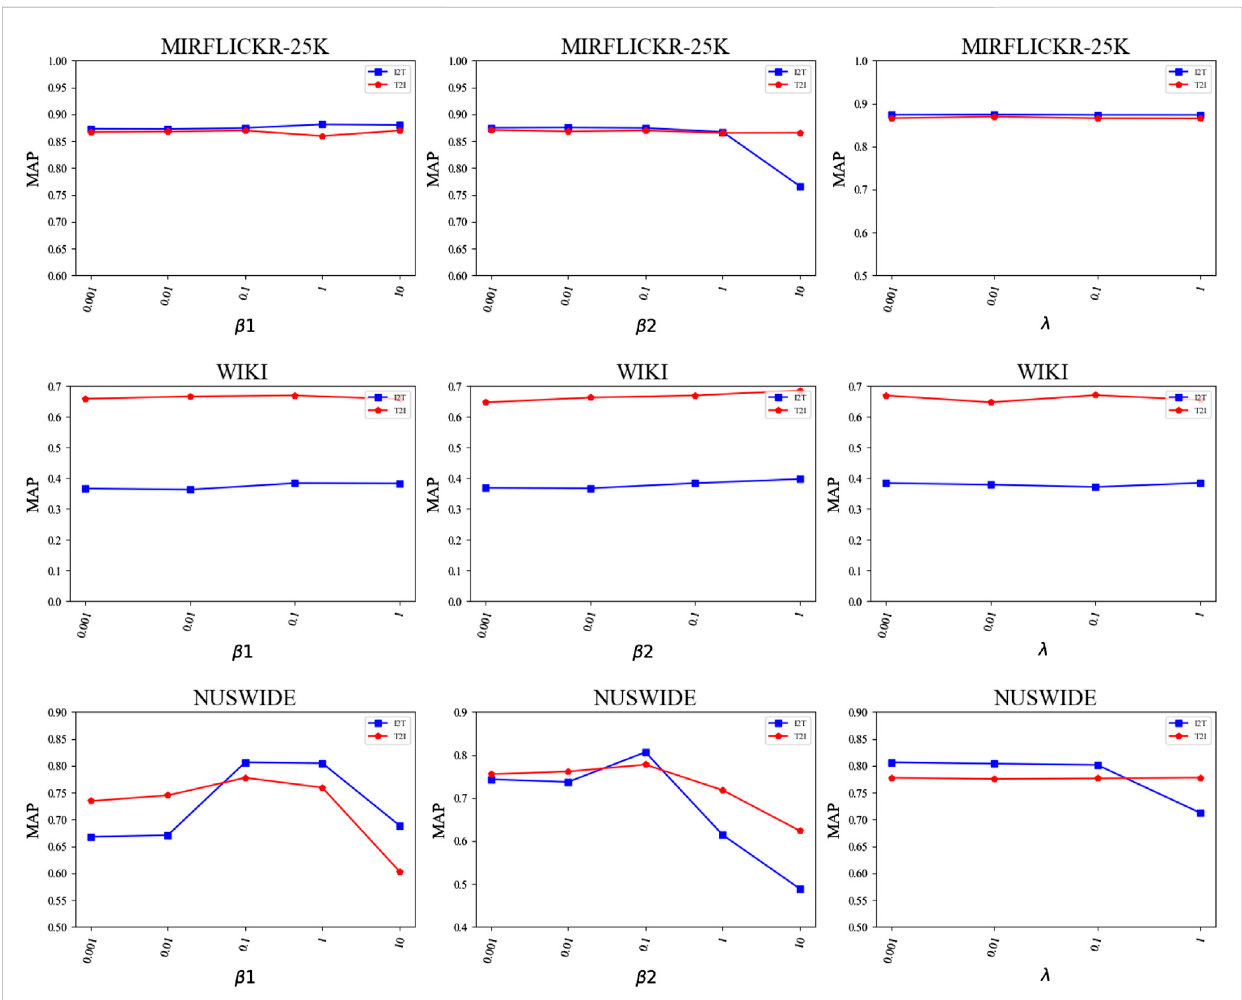
FIGURE 3 The retrieval performances of the FSSPDH method with different parameter